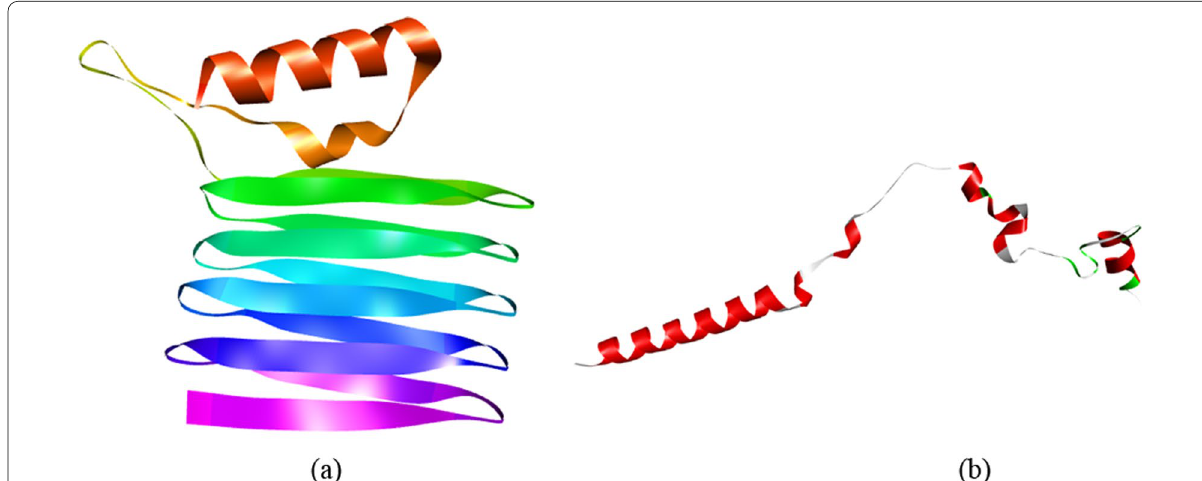
Fig. 2 a Prediction RosettaFold surface atom and limits in Discovery Software were used to illustrate the three-dimensional structure of the chimeric CsgA-MFP3 protein. a Major curli protein CsgA, and b foot protein 3 variant